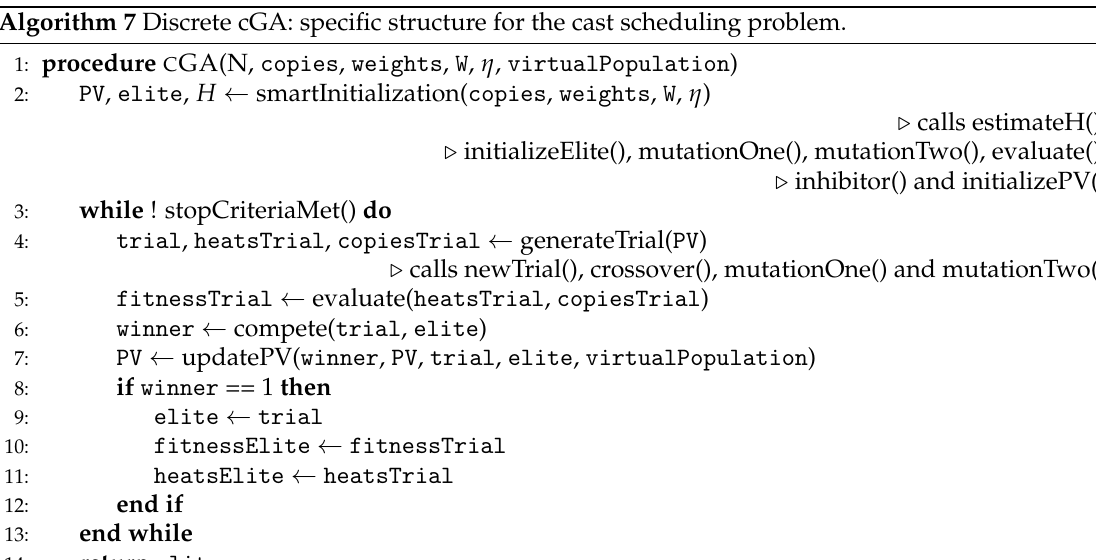
Algorithm 7 Discrete cGA: specific structure for the cast scheduling